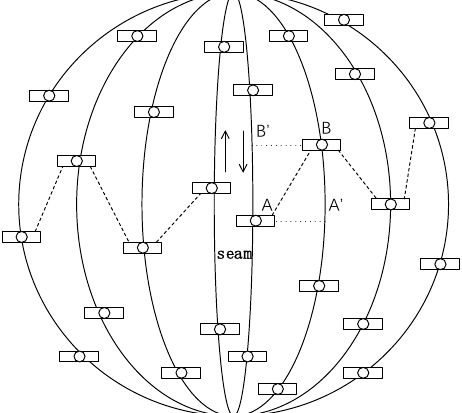
Figure 1. Polar orbiting satellite constellation configuration.